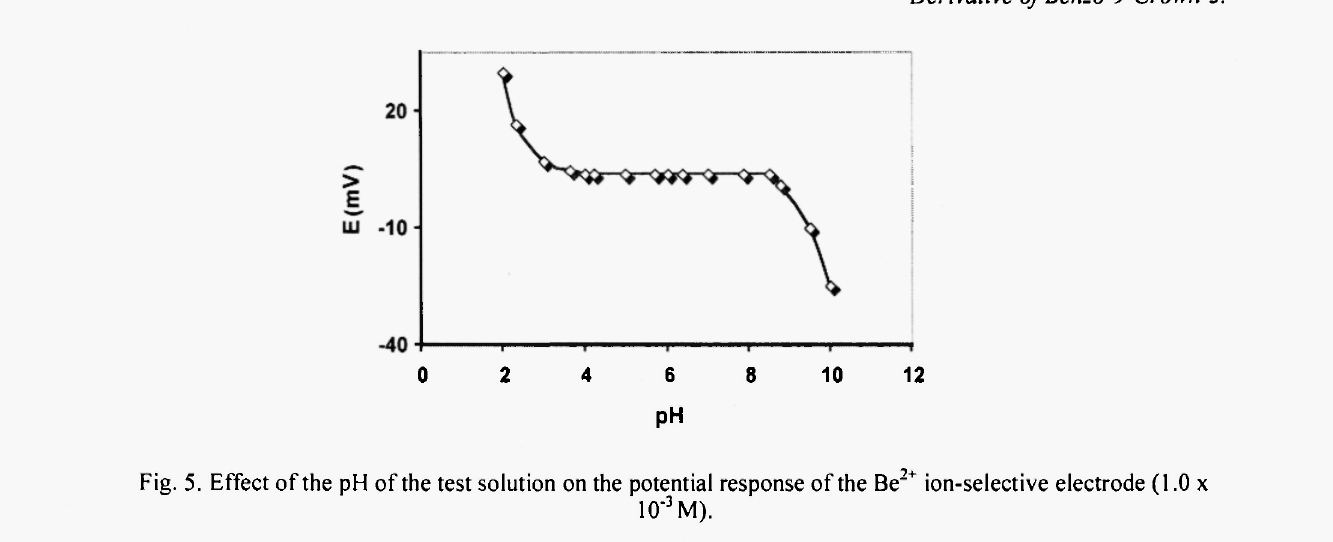
Fig. 5. Effect of the pH of the test solution on the potential response of the Be 2+ ion-selective electrode (1.0 χ 10' 3